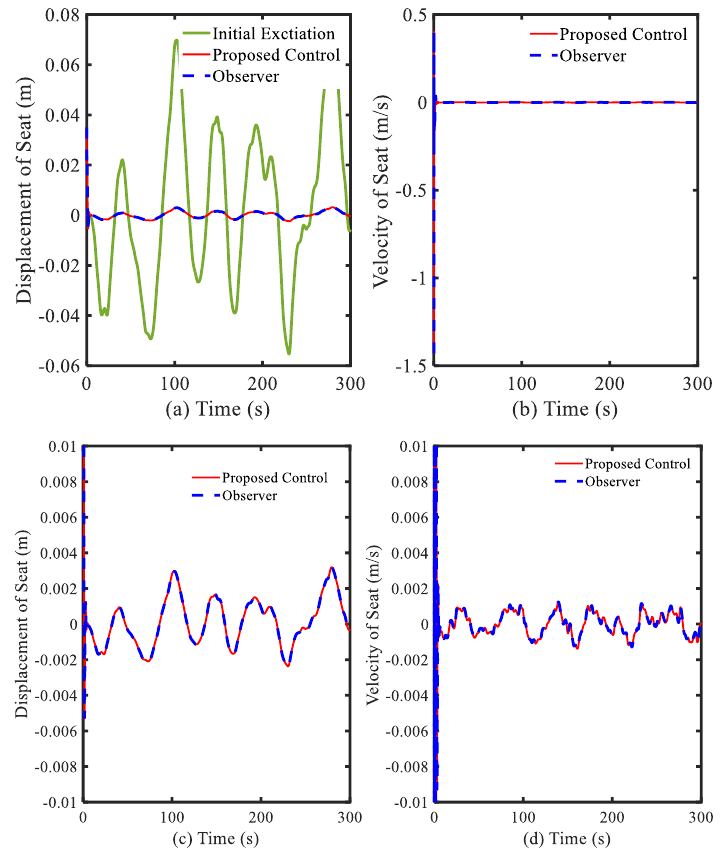
Figure 2. Simulation results of displacement of seat under random bump road excitation: ( a , b ) general view; and ( c , d ) large view.